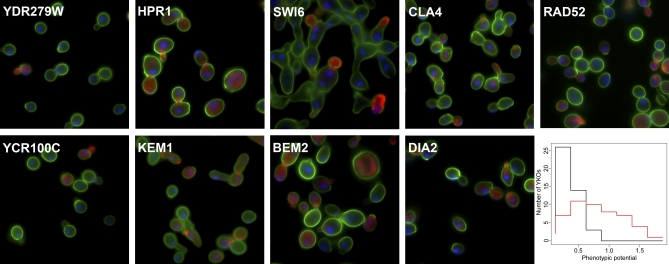
Phenotypic Capacitor YKOs Have Highly Variable and Distinct PhenotypesRepresentative micrographs from examples of putative phenotypic capacitor (HPR1, KEM1, SWI6, BEM2, CLA4, DIA2, RAD52) and control (YDR279W and YCR100C) strains are shown. Cells are stained with FITC-concanavalin A (green), rhodamine phalloidin (red), and DAPI (blue). Lower right: Histograms of the phenotypic potentials of control (black) and phenotypic capacitor (red) YKOs of haploid-converted heterozygous diploid strains.